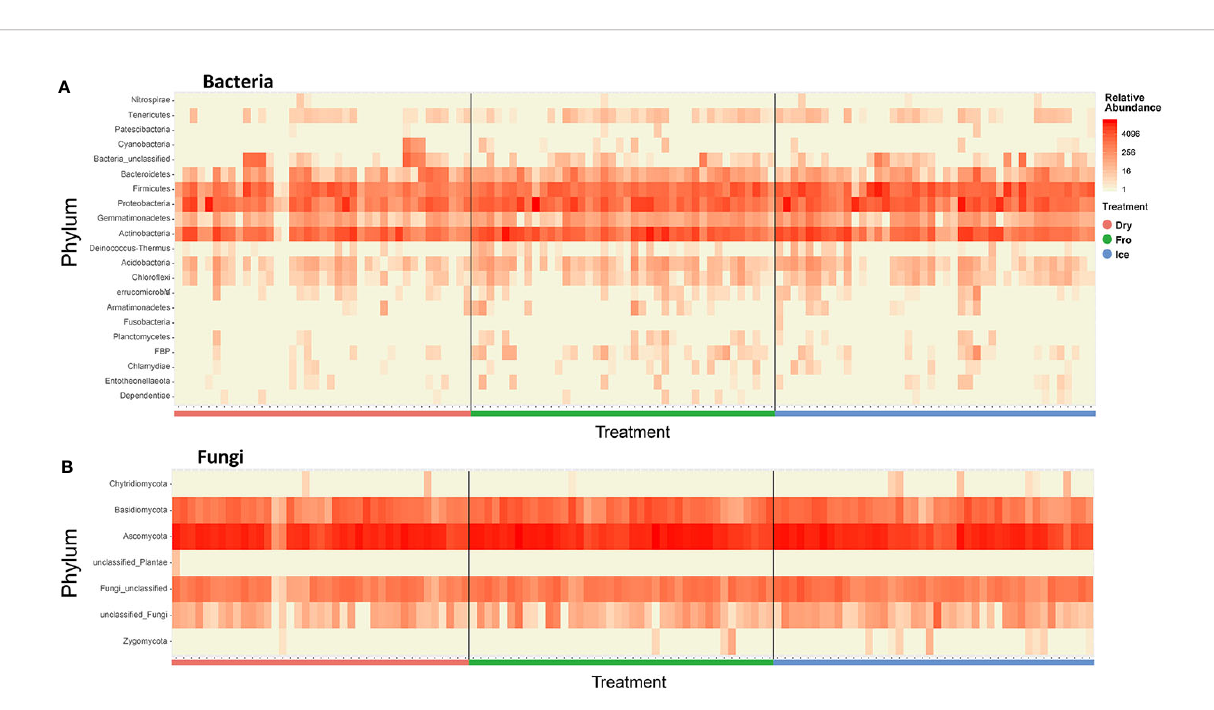
FIGURE 4 | Heatmap indicating relative abundance of bacterial (A) and fungal (B) phyla across all samples. Dry = air-dry (red), Fro = snap freezing (green), Ice = ice incubation